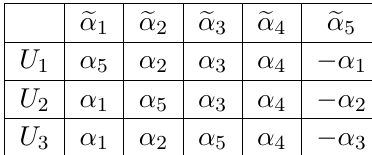
Table 3 . Transformation law of α -matrices under the unitary transformation by U 1 , U 2 and U 3